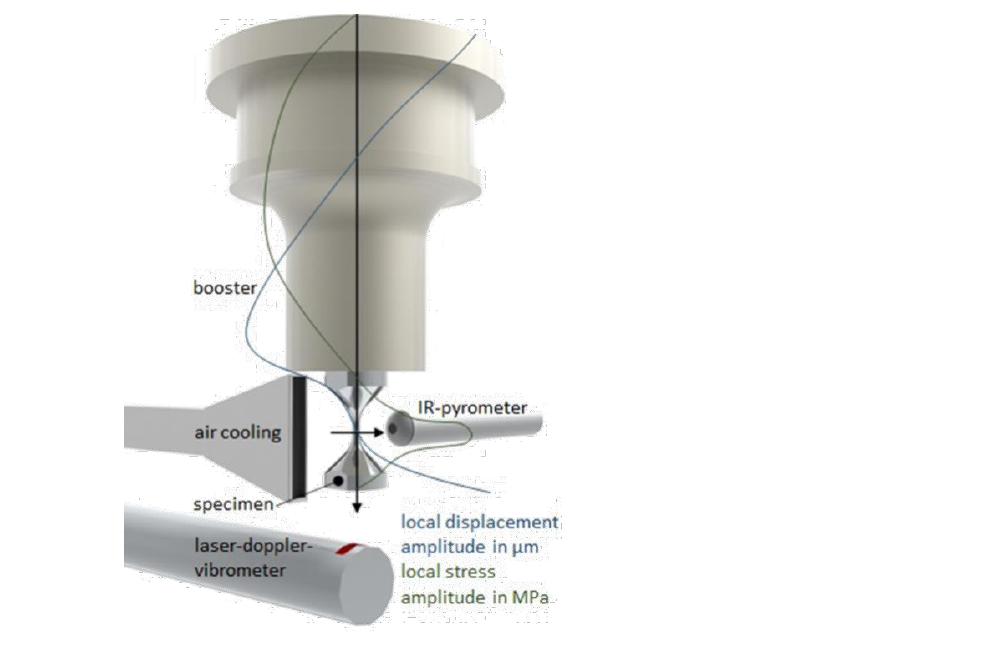
Figure 5. CAD sketch of an ultrasonic fatigue testing system including the local displacement amplitude and the local stress amplitude along the oscillation system, schematically .